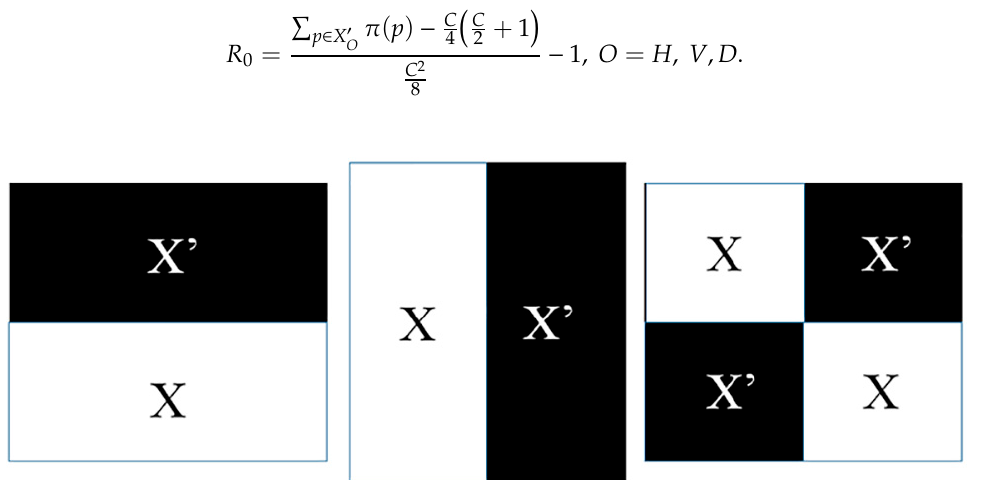
Figure 2. Illustration of comparisons of differences in three orientations used in the Ranklet transformation, including horizontal, vertical, and diagonal patterns.